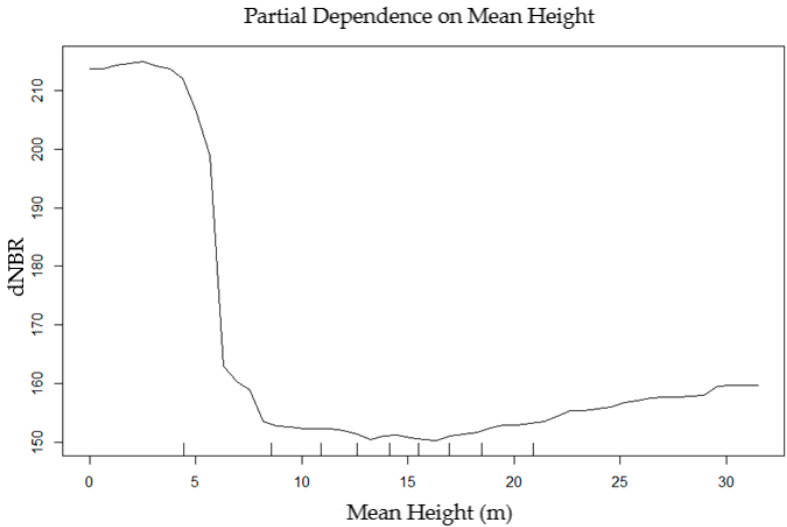
Figure 7. Mean canopy height of a 20 m pixel is likely to be below 7 m following fires with the highest severity. The dNBR was likely 60 points higher in shorter vegetation.